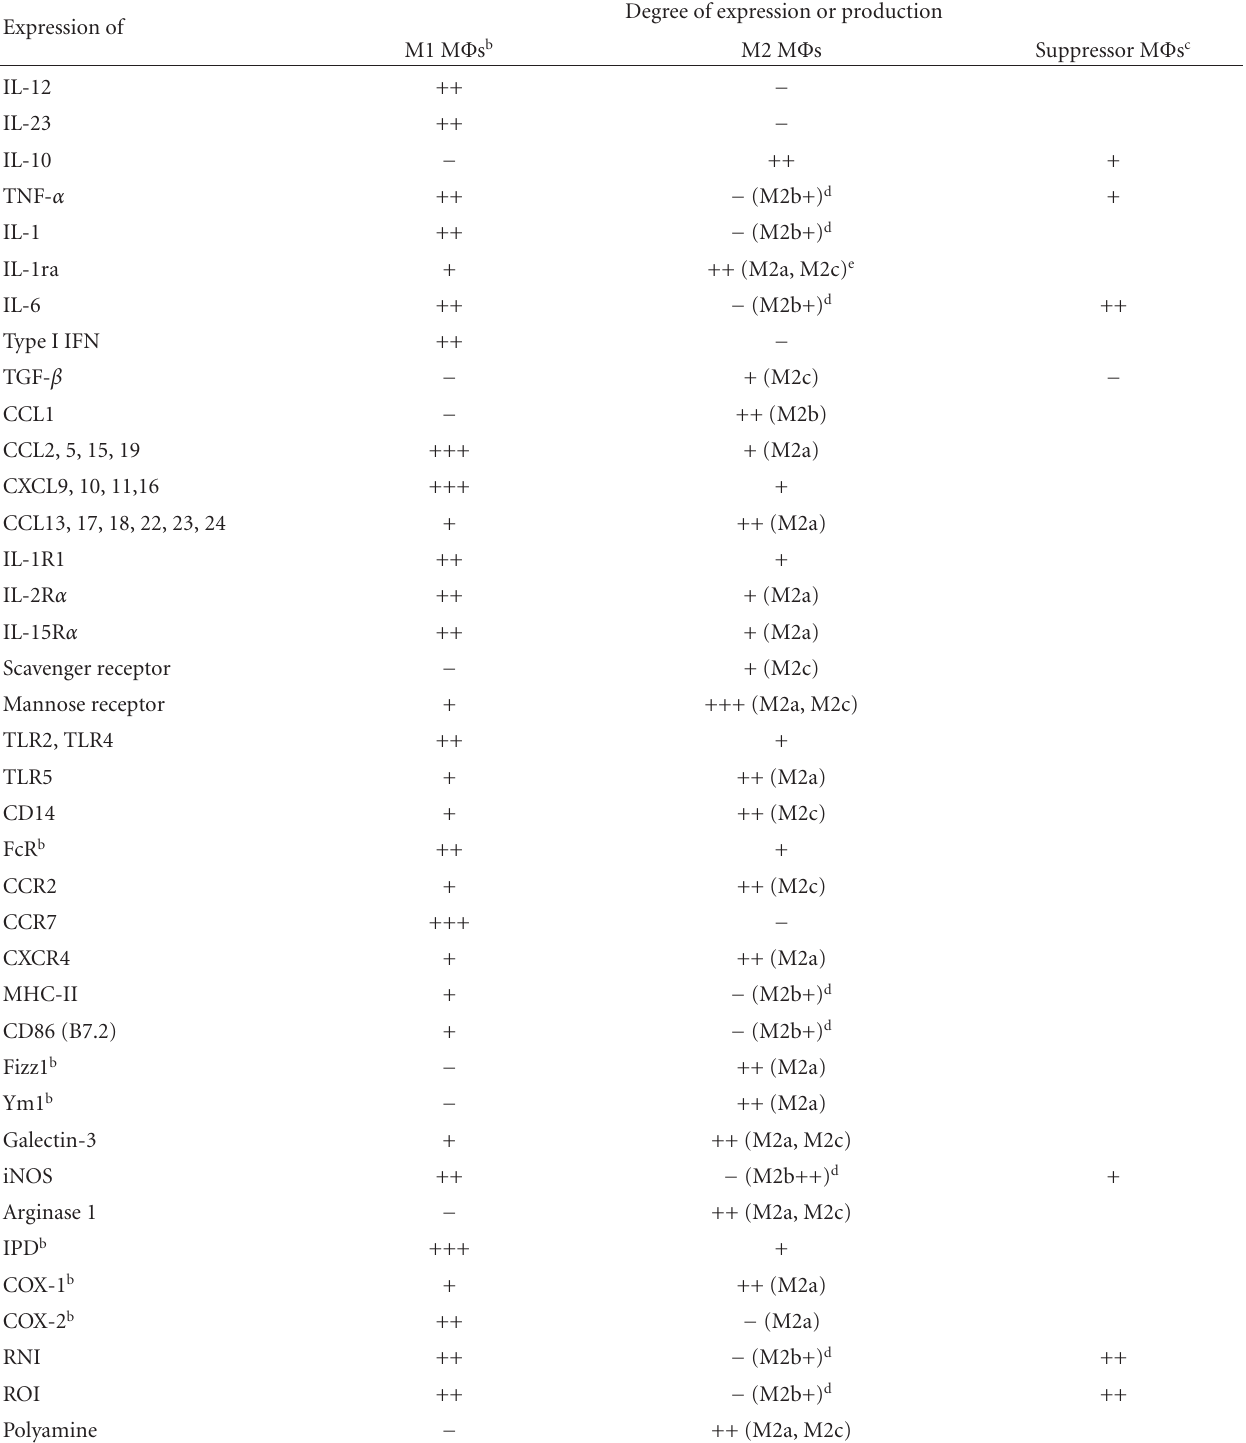
Table 1: Functional profiles of M1, M2, and suppressor macrophages a